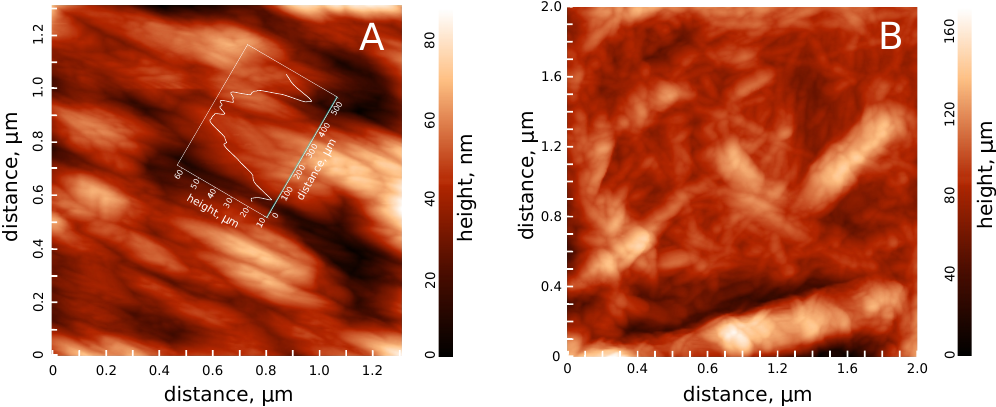
Figure 2. Typical atomic force microscope (AFM) images of the dried cellulose hydrosol. Cellulose was passed through the high-pressure homogenizer but was not sonicated. Some regions were composed of the more-or-less parallel elements ( A ), while in others, the cellulose elements crossed ( B ). The inset in ( A ) shows the horizontal relief